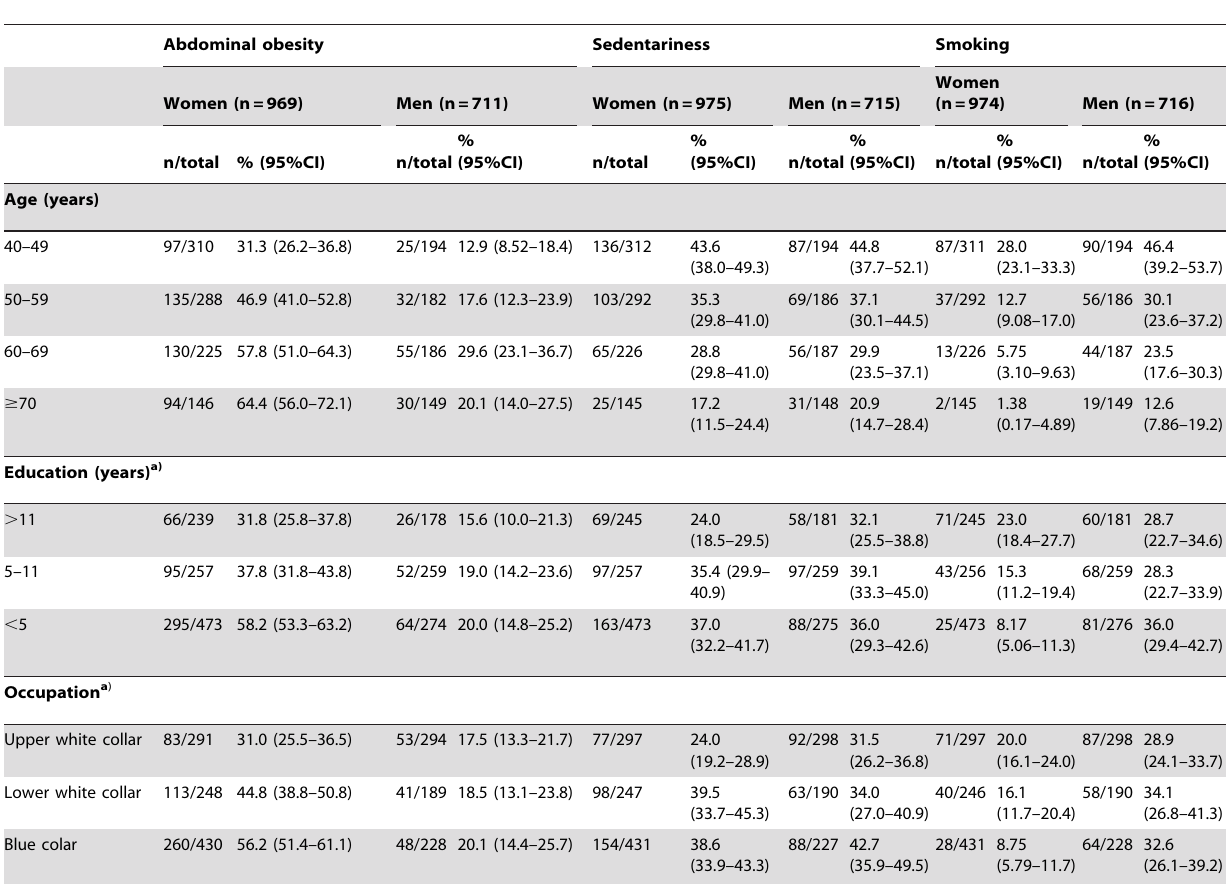
Table 3. Prevalence of abdominal obesity, sedentariness and smoking across age, education a) and occupation a) categories.